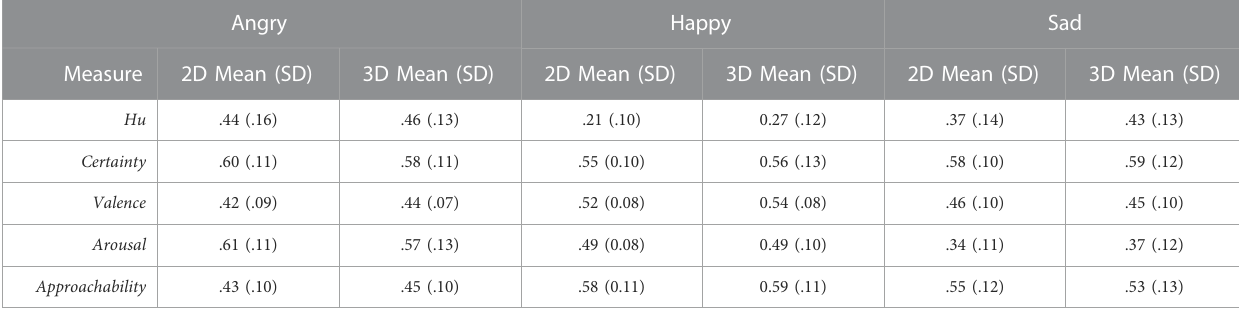
TABLE 3 Mean scores for unbiased hit rates (Hu), judgment certainty, perceived valence, arousal of the EBM, and approachability of the VC. Angry Happy Sad Measure